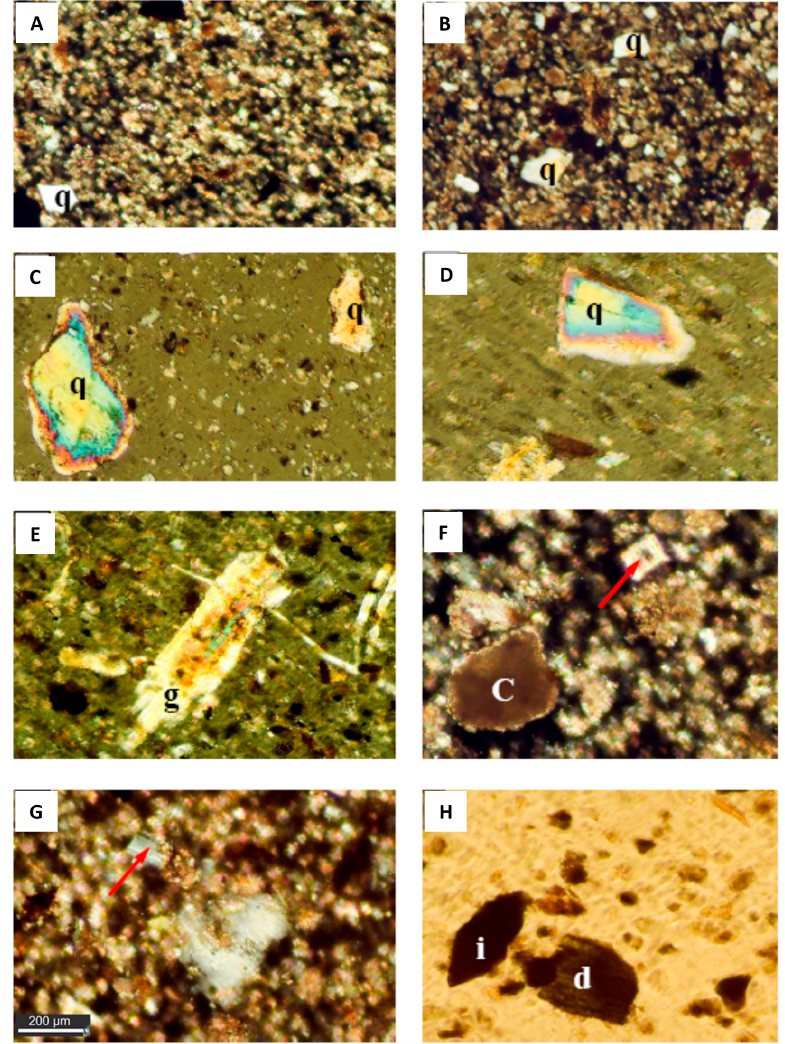
Figure 2. Photomicrographs showing the mineralogical composition of the dust fallout during the studyp. The background is composed of highly ferroginous microcrystalline calcite and clay minerals with scattered angular quartz (q) grains (Crossed Polar, 10X; image ( A ) and ( B )); Images ( C ) and ( D ) show subangular to subrounded quartz (q) grains showing the evidence of wear and iron oxide inclusions. In these micrographs the gypsum crystal (arrow) in photo ( D ) and ( E ) (Crossed Polar, 10X) is well developed gypsum crystal; whereas the micrograph (g) shows iron inclusions (Crossed Polar, 10X); ( F ) zoned dolomite crystal (arrow) in a background of dolomitized calcite. Clay film (c) appears over calcite (Crossed Polar, 20X); ( G ) Plagioclase crystal (arrow) showing lamellar twining (Crossed Polar, 20X); ( H ) Green hornblende (d) and iron aggregate (i).